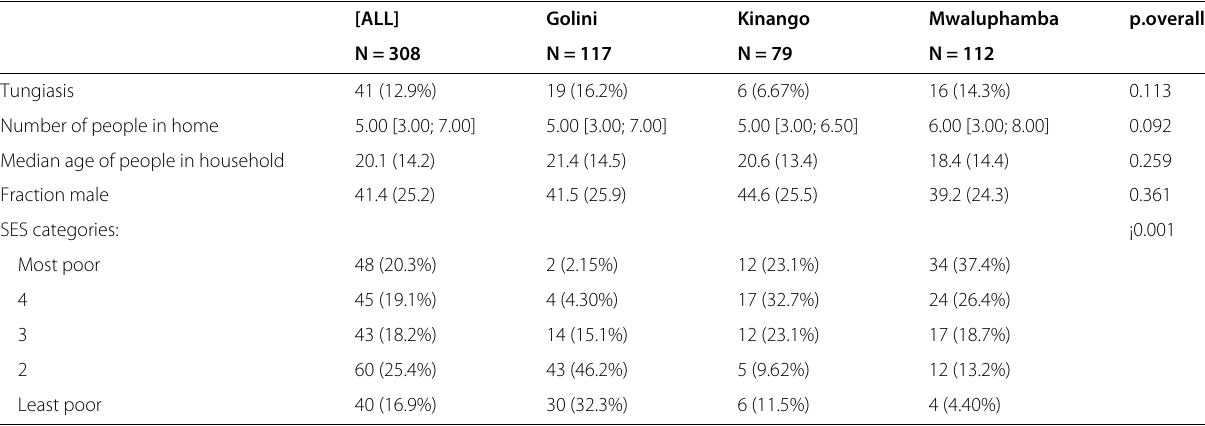
Table 1 Demographic comparison of sampled regions